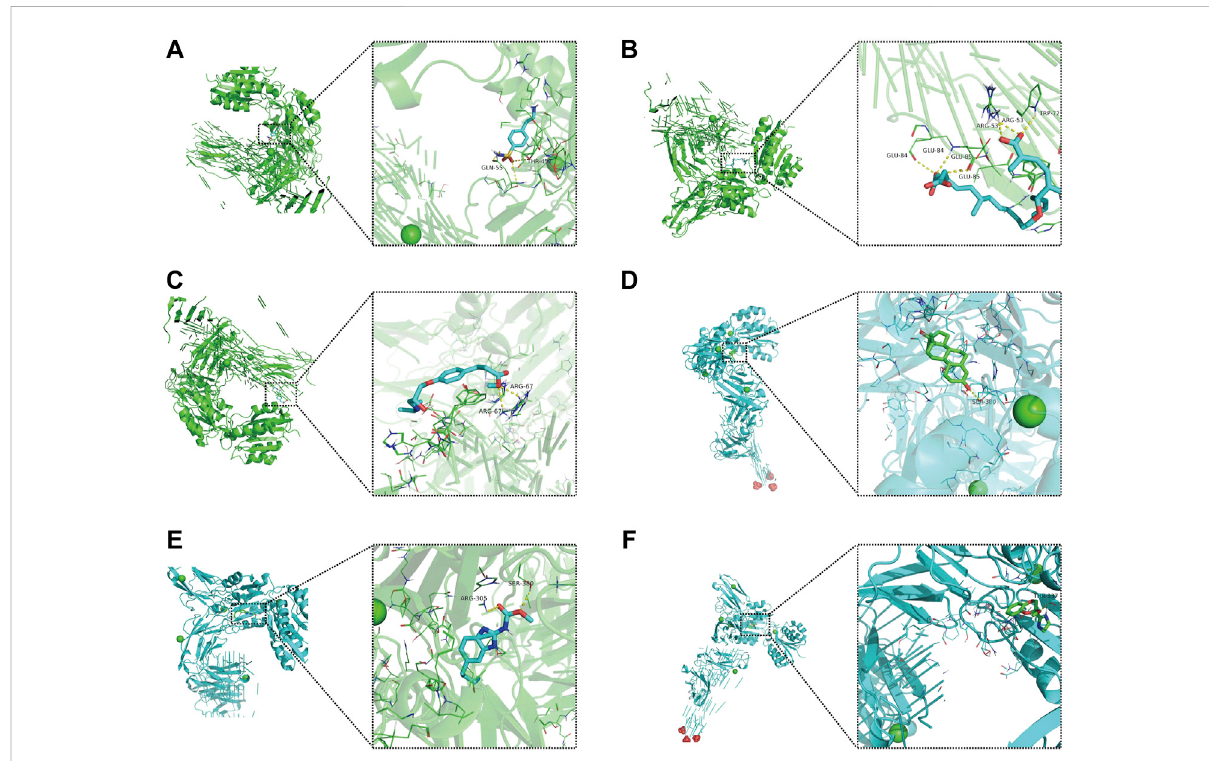
FIGURE 11 Molecular docking of small-molecule drugs and core molecular targets. (A) Parbendazole-CLCA1. (B) 4-(2-Aminoethyl) benzenesulfonamide- ZG16. (C) Bongkrek-acid-ZG16. (D) Norethisterone-CLCA1. (E) Esmolol-ZG16. (F) RX-821002-CLCA1.